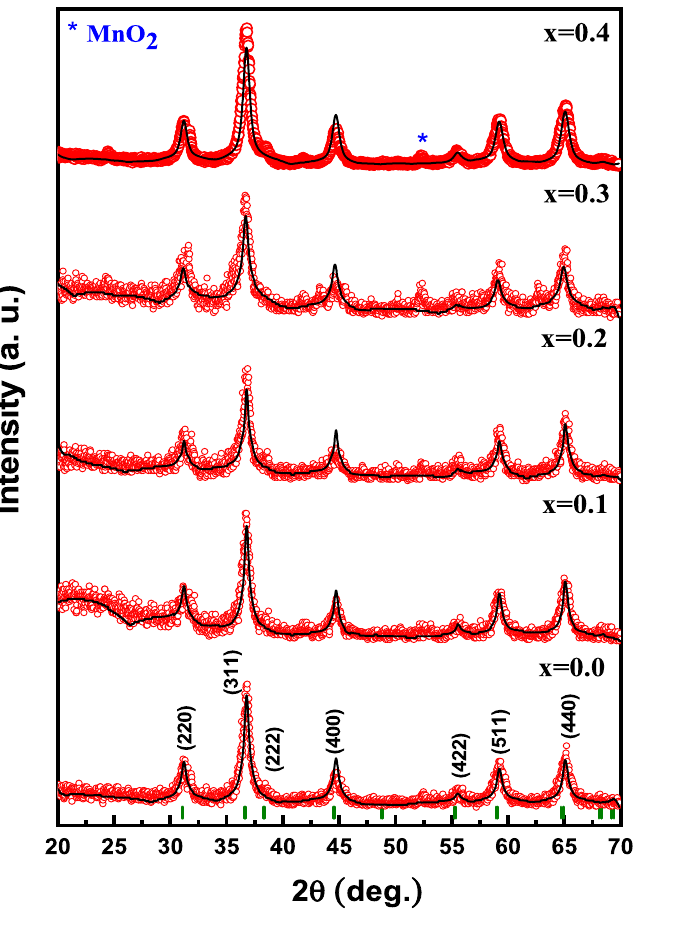
Figure 1. XRD powder patterns of V x -MnCo (x ≤ 0.4) MCs.